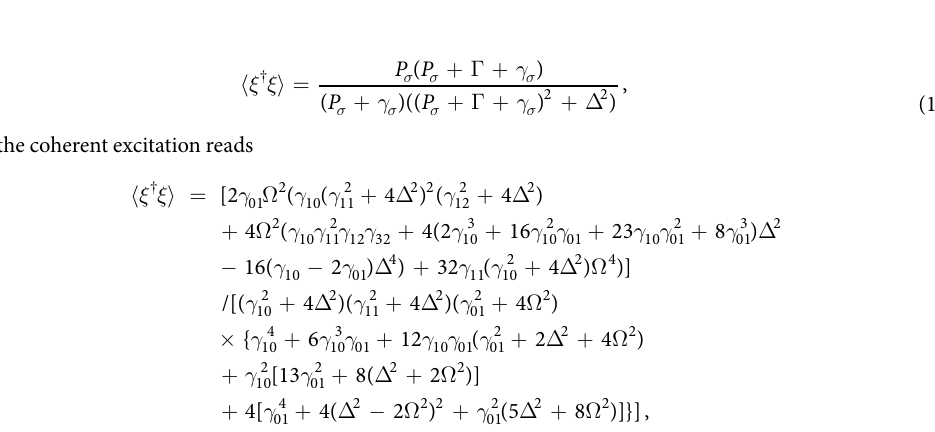
Figure 5. Effective quantum state reconstruction from the emission of a two-level system under high ( a ) incoherent and ( b ) coherent excitation. The various blue areas correspond to different filters linewidths. The light filtered in this way is equivalent to an unfiltered emitter whose quantum state has distribution p ( n ) to have n excitations, and is shown in ( b ) and ( d ), respectively. For the incoherently driven two-level system, case (a), the system is kept in its excited state by large pumping, so that without filtering, one observes a state close to the Fock state p ( n ) = δ n ,1 . Filtering leads to thermalization, with preponderance of vacuum but nonzero probability to detect > n 1 particles. The same is observed for the coherently driven two-level system, case (b), but starting from p (0) = p (1) = 1/2 due to the no-inversion of a two-level system in presence of stimulated emission. Parameters: for incoherent excitation, P σ = 10 2 γ σ (saturating the two-level system). For coherent excitation, Ω = 5 γ σ . The rest of the parameters are as indicated in the